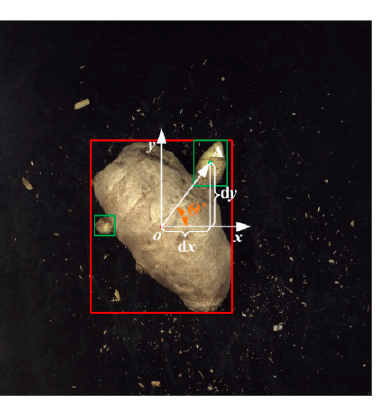
Figure 6. Calculation of ginger shoot orientation angle.